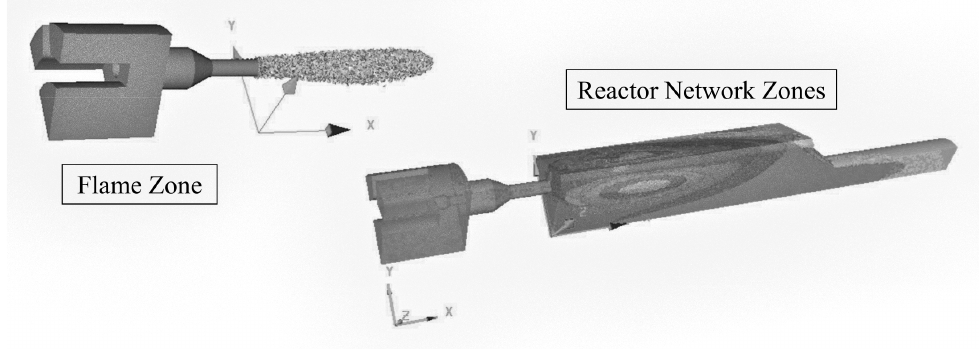
Figure 10. Results of zone identification by Energico for the flame zone and reactor network